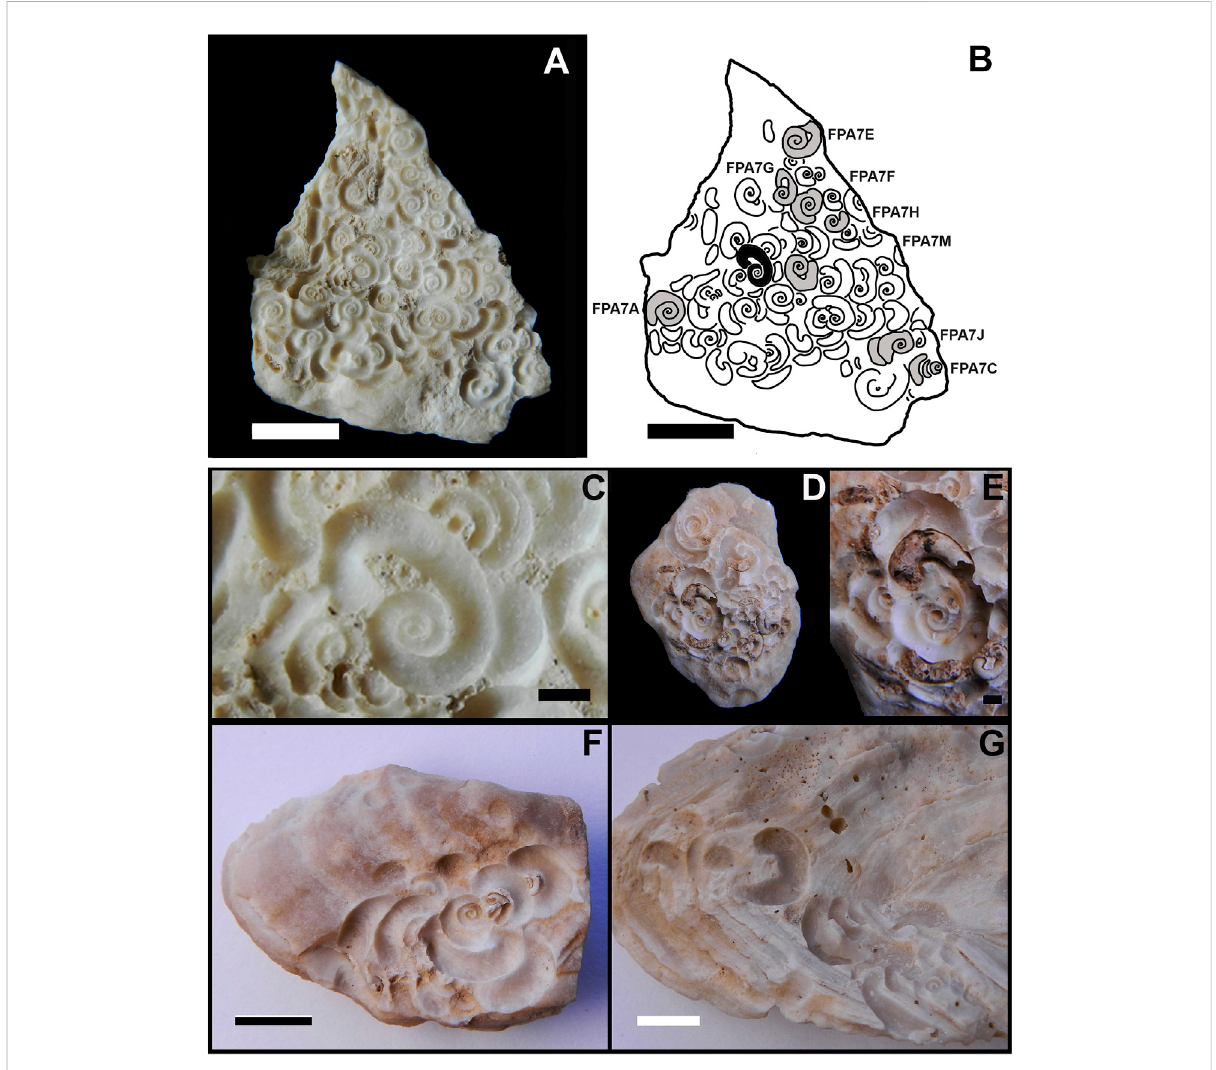
FIGURE 5 Santichnus mayorali ichnogen. nov., ichnosp. nov. (A) whole sample bearing holotype (FPA 7 K). (B) holotype location is highlighted in black on the sample and other specimen locations on the same surface. (C) detail of holotype. (D,E) : paratype (ULL PA 469). (D) whole sample with paratype and other specimens. (E) detail of paratype. (F) three clearly compound specimens of Renichnus – Santichnus (ULL PA 472). (G) Specimens of Renichnus and Santichnus (lower right corner), occurring closely but not clearly in a compound association (ULL PA 467). Scale bars: (A,B,D) 5 mm and (C,E) 1